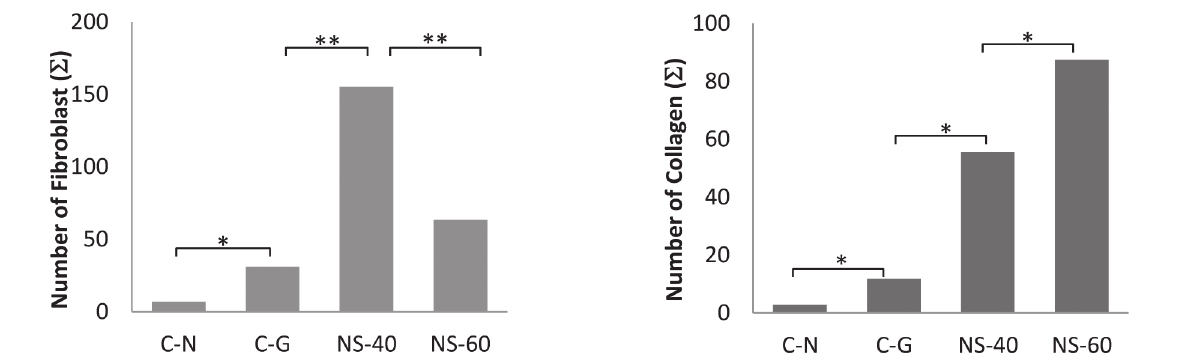
Figure 4. number of Fibroblast. Mann Withney: * p < 0.05; ** p > 0.05